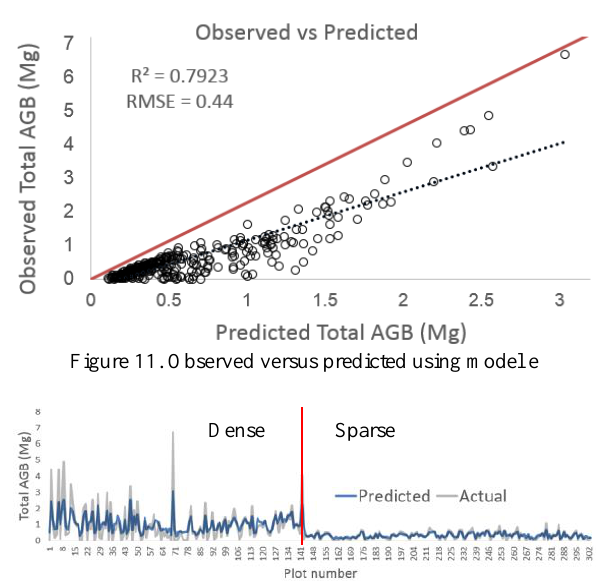
Figure 12. Observed versus predicted using model e